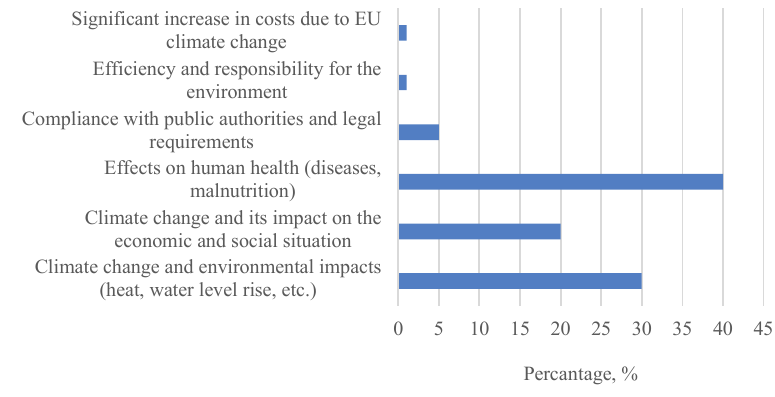
Fig. 10. What reasons are the most relevant in the context of CO 2 emission to